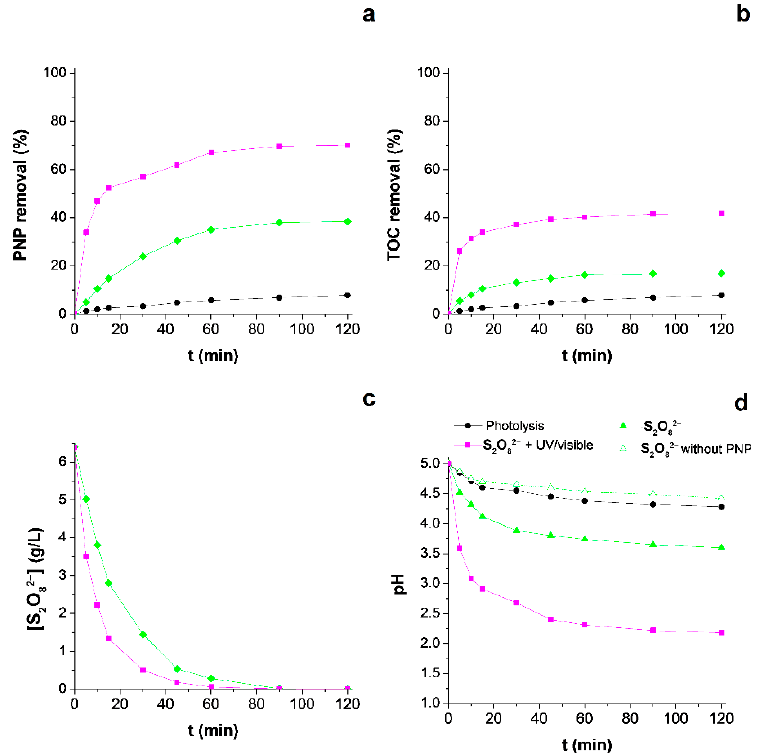
Figure 1. Evolution of p -nitrophenol (PNP) ( a ) and total organic carbon (TOC) ( b ) removals, concentration of persulphate remaining in solution ( c ) and pH ( d ) during photolysis, persulphate alone and persulphate activated with UV/visible light ([PNP] o when used = 500 mg/L, pH = 5.0, T = 30 °C, I when used = 500 W/m 2 and [S 2 O 82 − ] o,when used = 6.4 g/L).